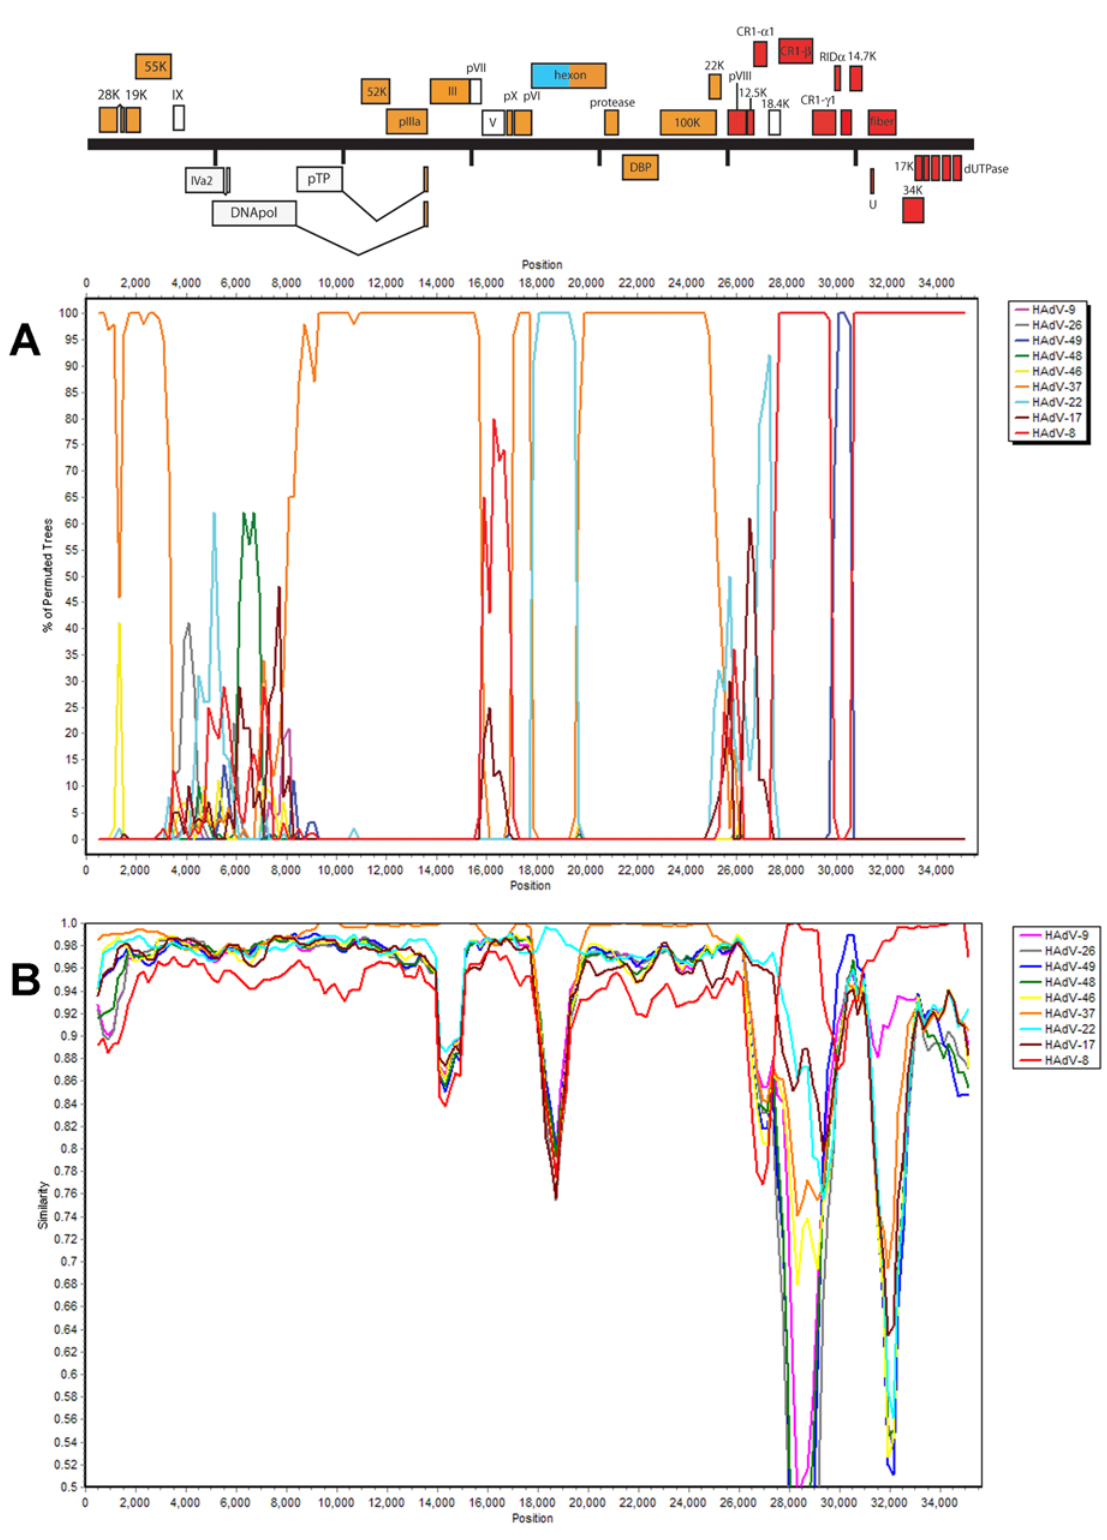
Figure 2. Whole genome (A) bootscan and (B) simplot of HAdV-D53 compared to fully sequenced HAdV-D genomes.